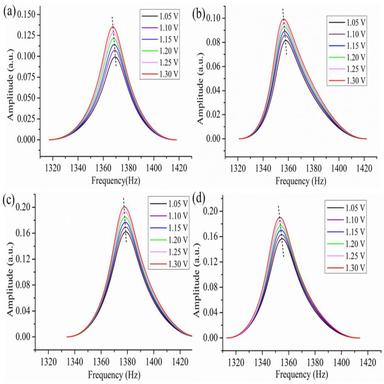
Resonant spectrum of four specimens: (a) 2400 impacts with impact energy of 3 J, (b) 1200 impacts with impact energy of 4 J, (c) 800 impacts with impact energy of 5 J, and (d) 20 impacts with impact energy of 7 J.